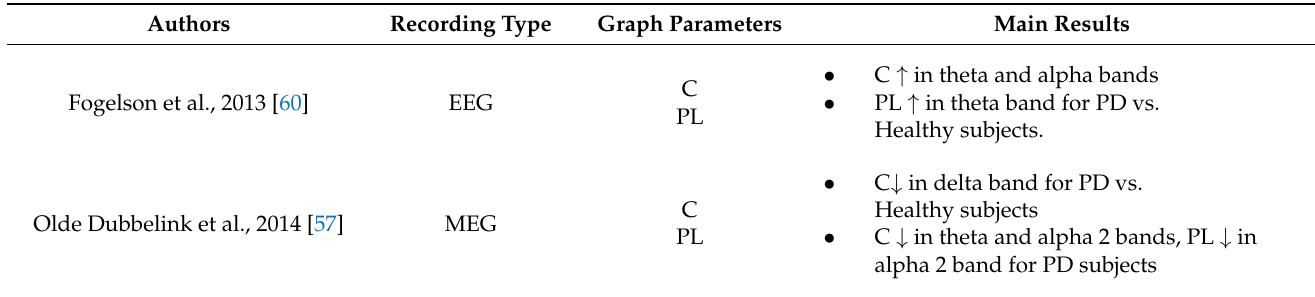
Table 3. Summary of the main results of PD studies reported in the present